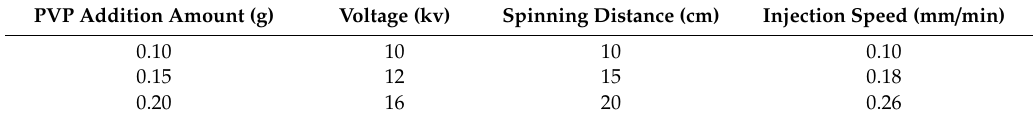
Table 1. The main range of the experimental